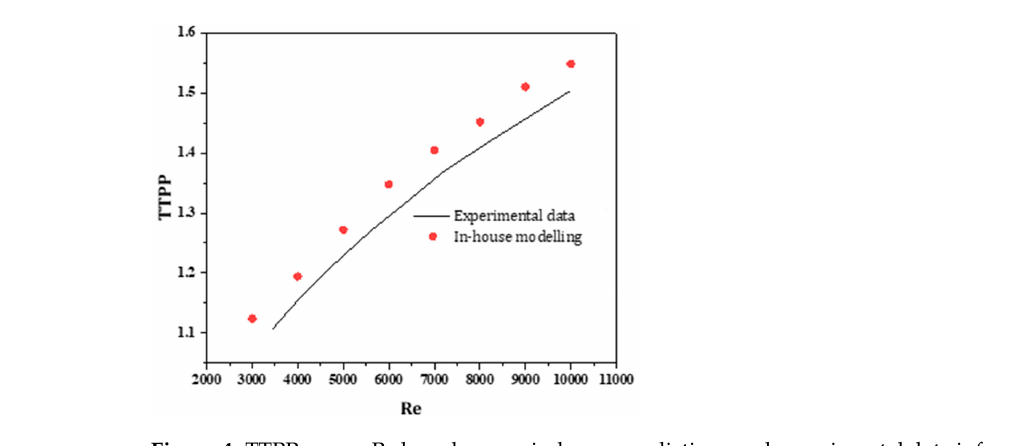
Figure 4. TTPP versus Re based on our in-house predictions and experimental data inferred from [16].